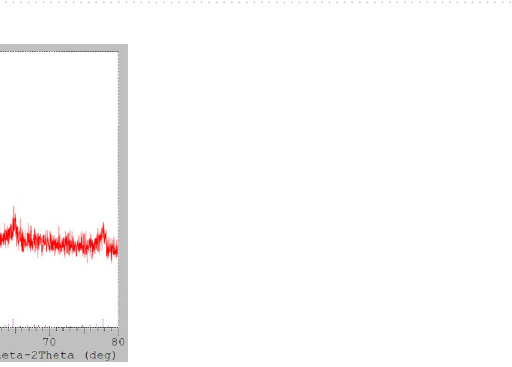
Figure 7. Transmission Electron Microscope (TEM) micrograph of ( A , B ) C. sinuosa algal aqueous extract and ( C , D ), synthesized silver nanoparticles from C. sinuosa extract.